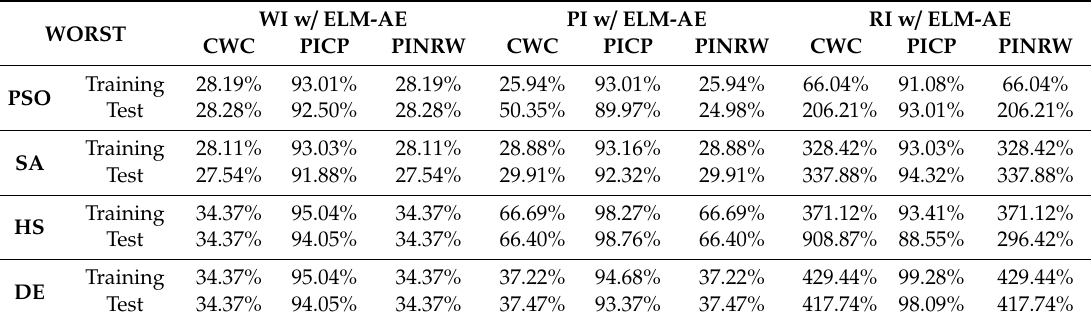
Table 3. Comparison of the worst results of di ff erent cases with ELM-AE.